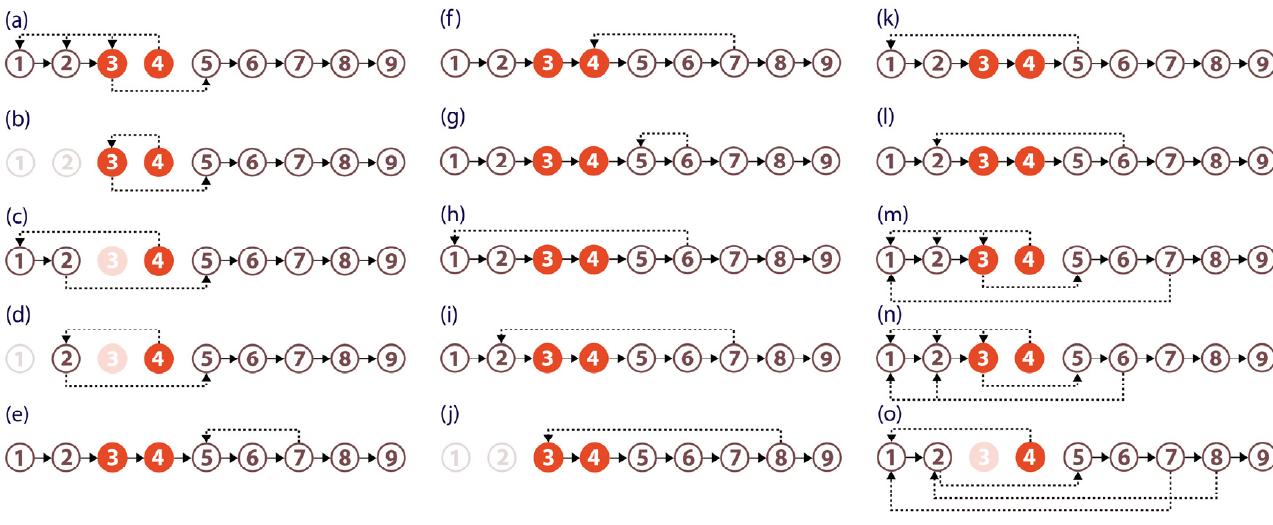
Figure 8. Examples of IDTPMM nonlinear process model ( ① – ⑨ represent the 9 steps of IDTPMM process model; Red indicates core steps; light colors indicate steps not involved in the process; other colors indicate routine steps). ( a – d ) The Non-linear thinking processes with programmed control as the main purpose.( e – l ) The non-linear thinking processes with the main purpose of designing application innovation.( m – o ) The non-linear thinking processes that includes both design fundamental research and design applied research.